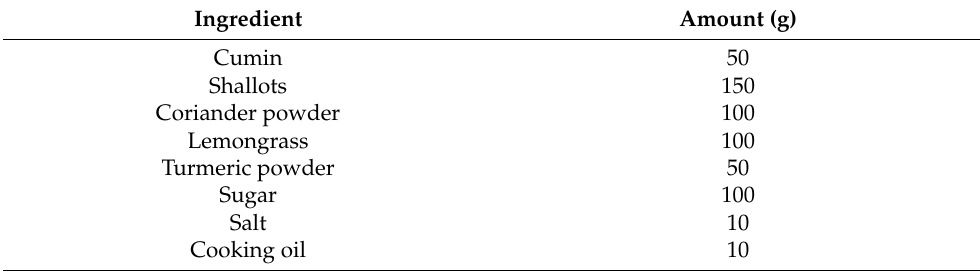
Table 1. Amount of ingredients used for the preparation of marinades (for 1 kg meat). Ingredient Amount (g) Cumin 50 Shallots 150 Coriander powder 100